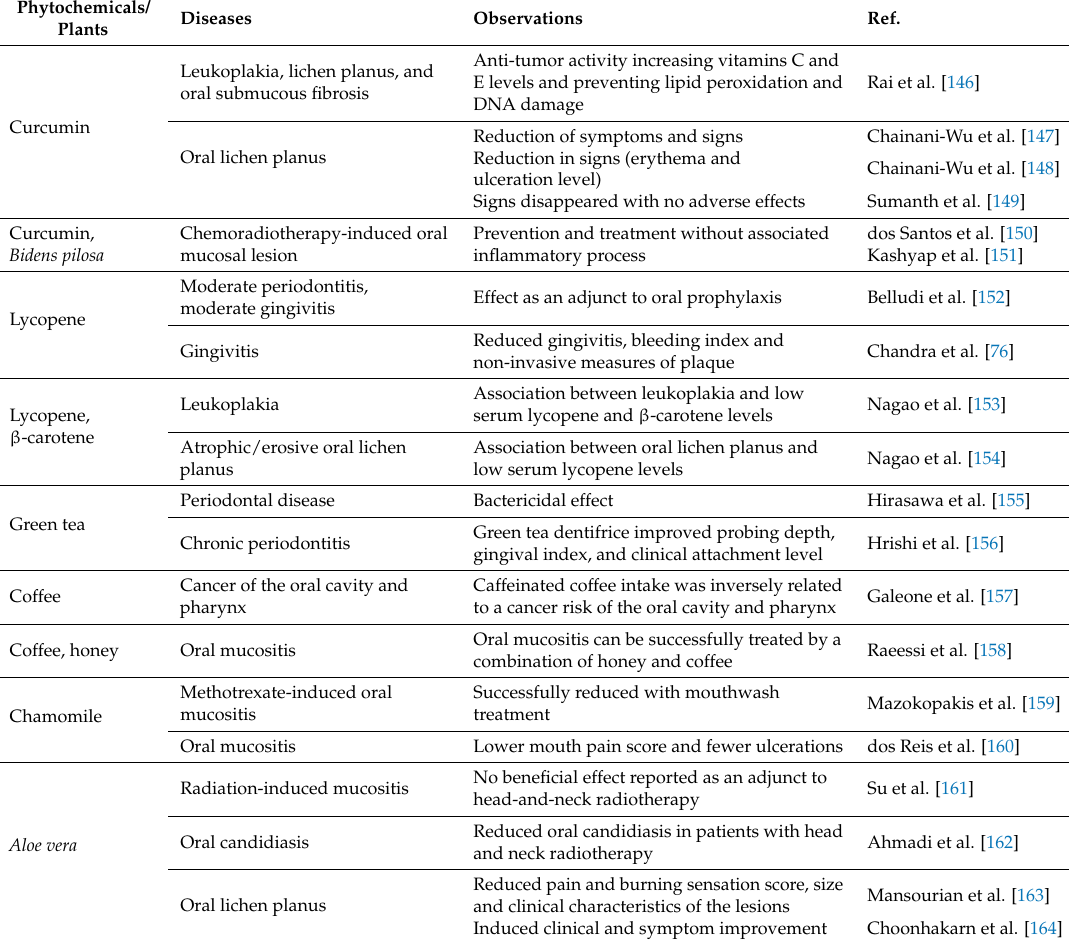
Table 3. Human evidence of plants and phytochemicals against oral mucosal